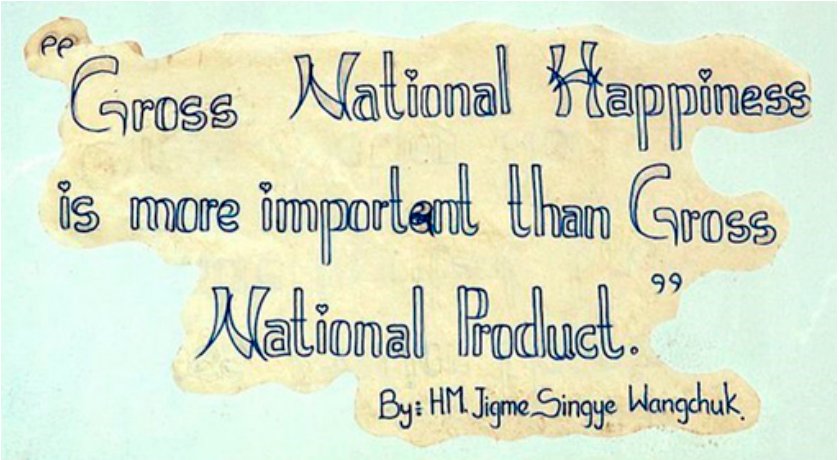
Figure 6. The dedication to cooperation issues in different parts of the world showed that in certain countries, as in Bhutan, the philosophy of life is to be taken into consideration.